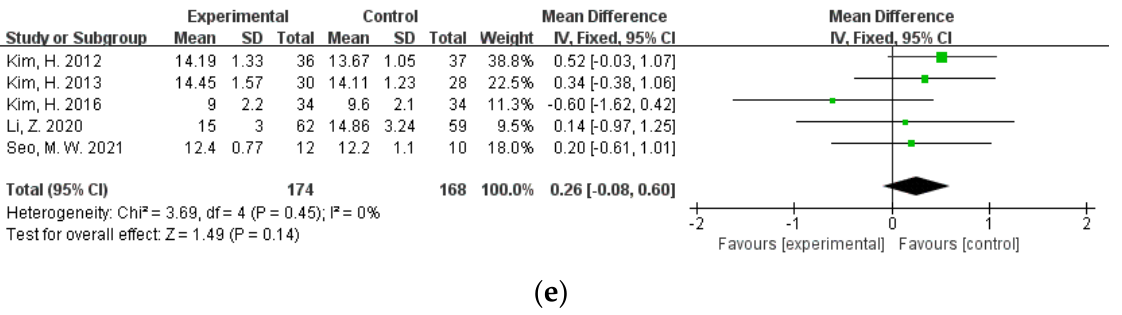
( b ) Figure 6. Forest plot for physical performance. ( a ) Forest plot of the effectiveness of exercise interven- tions for walking speed improvement in older adults with sarcopenia; ( b ) forest plot of the effective- ness of exercise interventions for functional mobility improvement in older adults with sarcopenia.